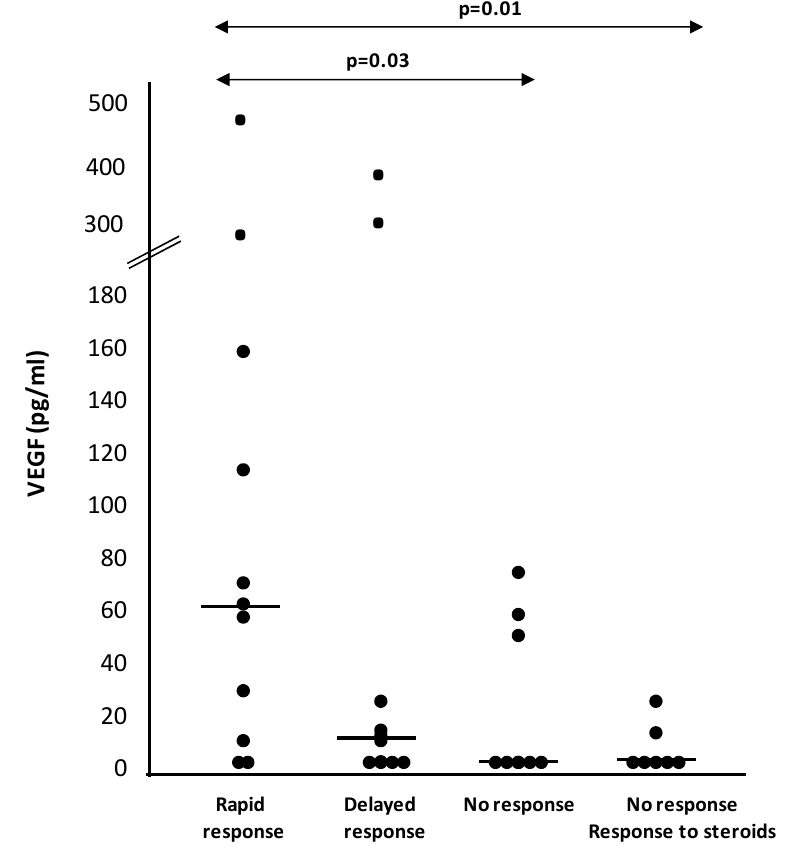
Figure 1. VEGF levels in aqueous humor according to response. Individual data points, median (horizontal bar symbols) and p values are shown.